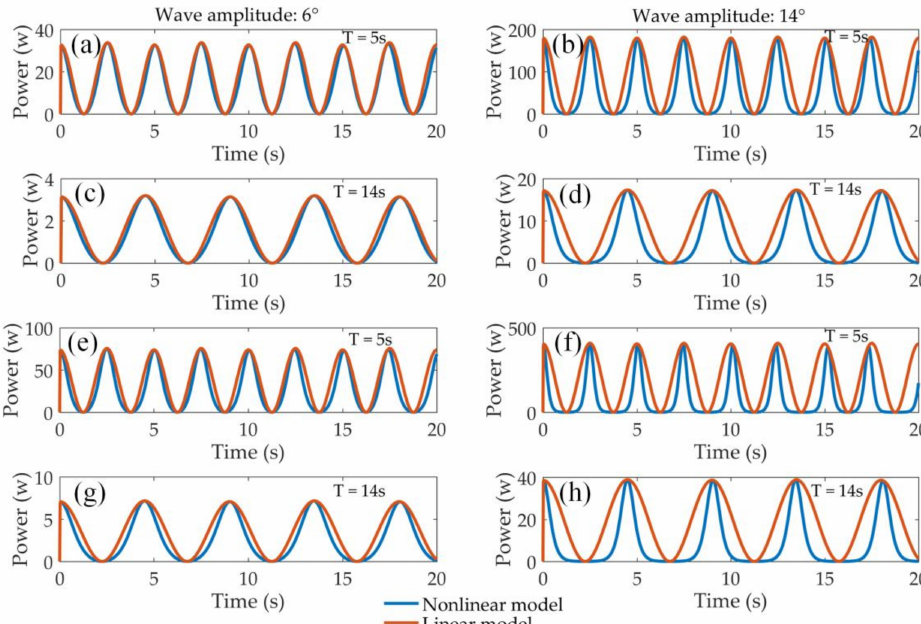
Figure 7. Comparison of power output between linear and nonlinear systems (linearized system: . ϕ = 8000 rpm; ( b ) A = 14 ◦ , T = 5 s, red line, nonlinear system: blue line): ( a ) A = 6 ◦ , T = 5 s, . . . ϕ = 8000 rpm; ( c ) A = 6 ◦ , T = 14 s, ϕ = 8000 rpm; ( d ) A = 14 ◦ , T = 14 s, ϕ = 8000 rpm; ( e ) A = 6 ◦ , . . . ϕ = 12,000 rpm; ( f ) A = 14 ◦ , T = 5 s, ϕ = 12,000 rpm; ( g ) A = 6 ◦ , T = 14 s, ϕ = 12,000 rpm; ( h ) T = 5 s, . ϕ = 12,000 A = 14 ◦ , T = 14 s,